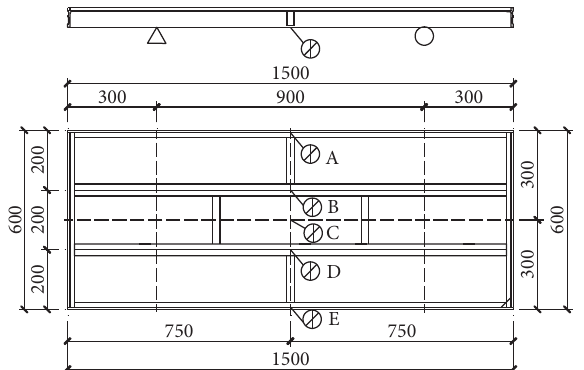
Figure 3: Arrangement of the measuring points of deflection in the single-span simply supported formwork.